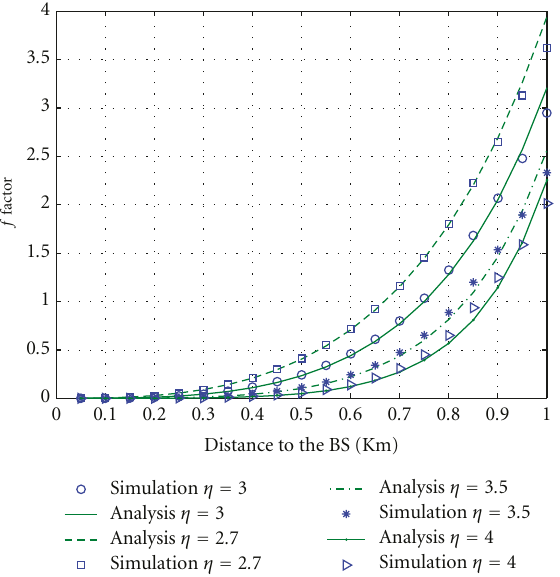
Figure 4: OCIF versus distance to the BS; comparison of the fluid model with simulations on a hexagonal network with η = 2 . 7, 3, 3 . 5, and